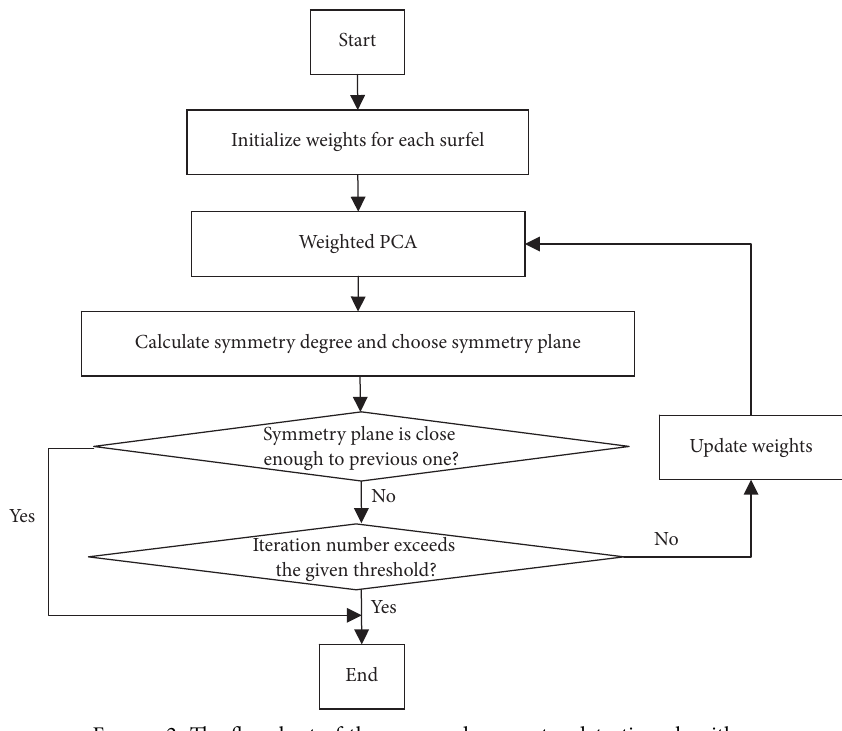
Figure 2: The flowchart of the proposed symmetry detection algorithm. algorithm, taking the bunny model for example. In Figure 4, the horizontal axis represents iteration numbers and the vertical axis represents the value of ε . The estimated sym- metry planes of the bunny model are also shown in Figure 4. From left to right, the iteration numbers are 1, 2, and 7, respectively. After the experiment, we found that the two symmetry planes are close enough when ε is less than 0.1.